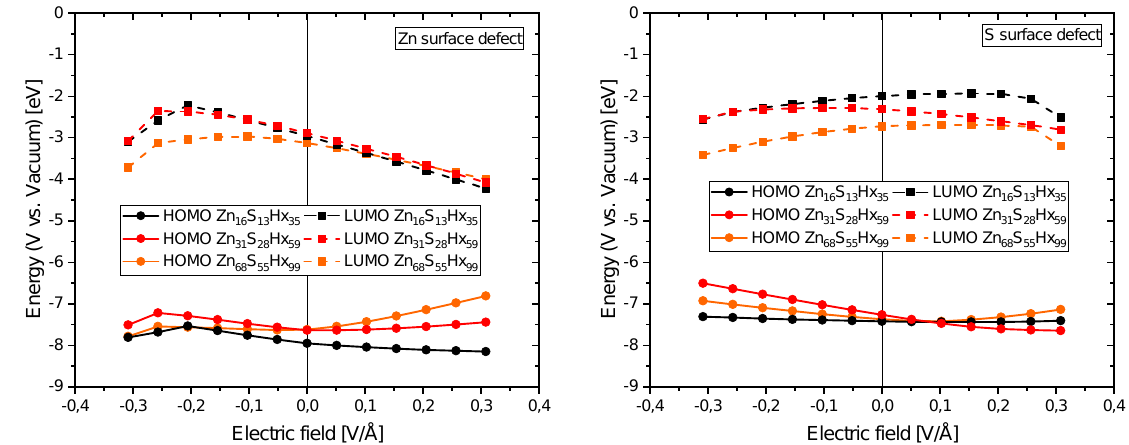
Figure A3. Absolute energetic position of the HOMOs and LUMOs for different sized QDs with Zn ( left ) or S ( right ) surface defects as a function of the applied electrical